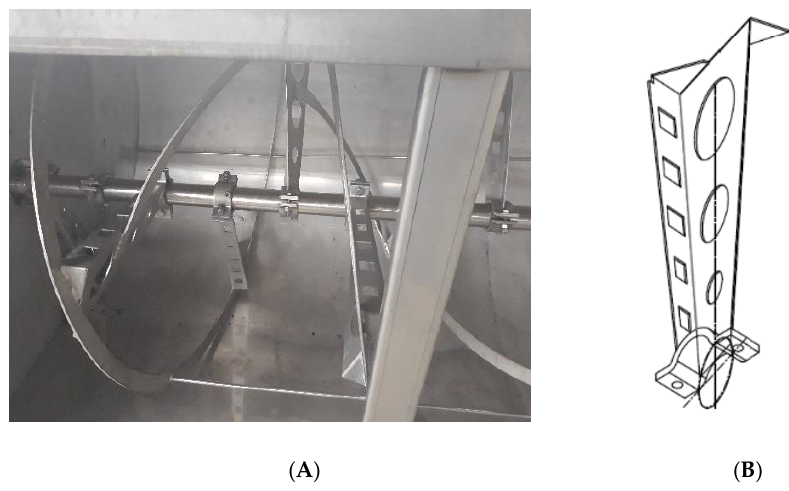
Figure 1. Details of the unmodified reel. ( A ) malaxer tank equipped with unmodified reel and ( B ) isometric view of the unmodified radial element of the reel.